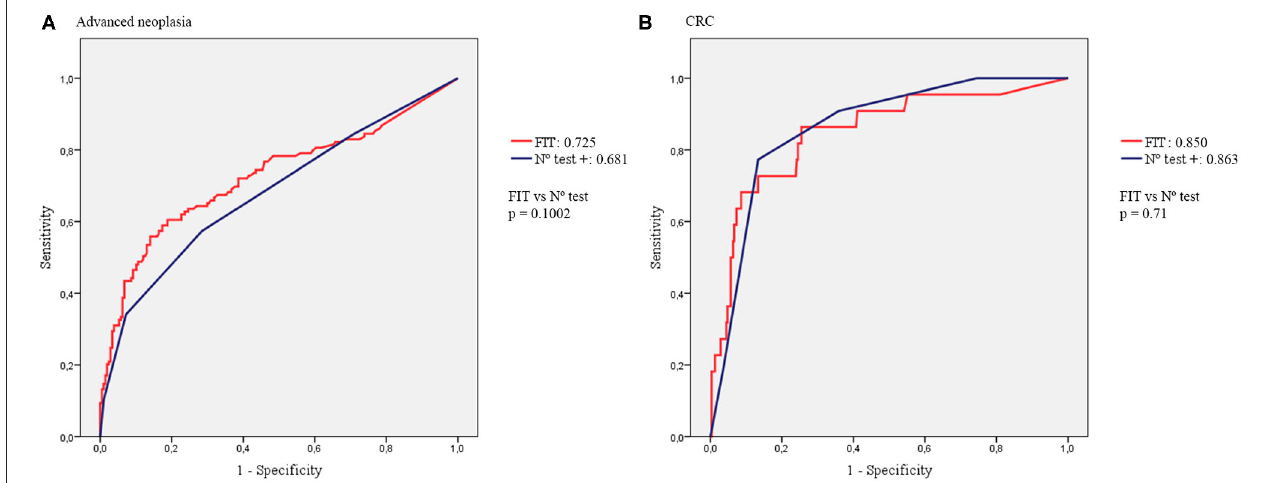
FIGURE 3 | AUCs of FIT compared with the combo test. (A) AUCs for the diagnosis of advanced neoplasia. (B) AUCs for the diagnosis of